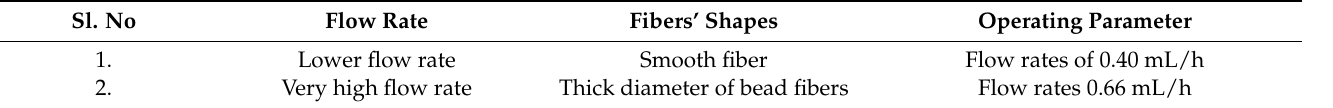
Table 5. Observations of smooth and bead fibers concerning the effect of flow rate. Sl. No Flow Rate Fibers’ Shapes Operating Parameter 1. Lower flow rate Smooth fiber Flow rates of 0.40 mL/h Very high flow rate Thick diameter of bead fibers Flow rates 0.66